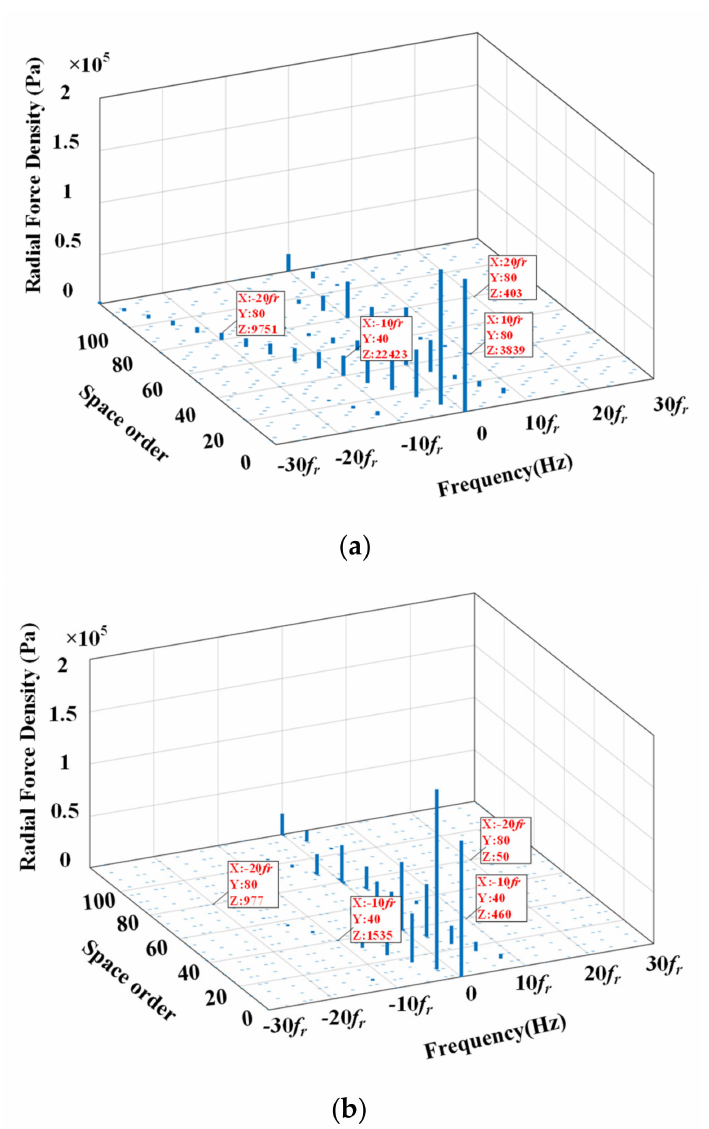
Figure 14. Harmonic analysis of the radial force density. ( a ) Mode 1. ( b ) Model 3.